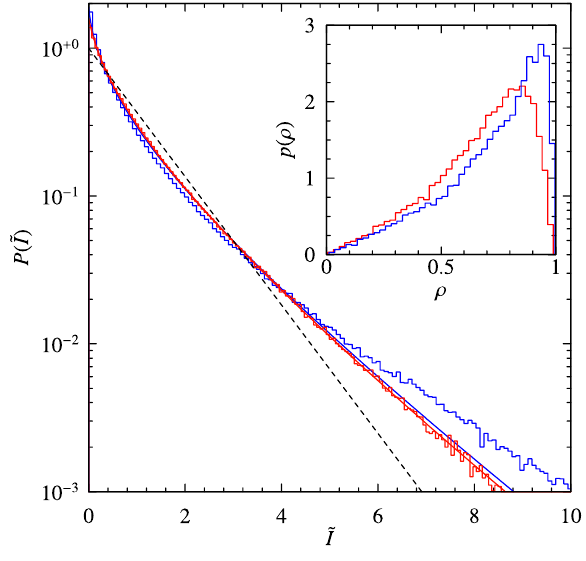
Figure 3: Empirical distributions of the normalised inten- sities: blue histogram for the conventional RC and red his- togram for the chaotic one. Comparison with the predic- tion Equation (6) (blue and red continuous curves) where the empirical p ( ρ ) was used (see inset with corresponding colors). The dashed black curve shows the exponential dis- tribution expected under Hill’s hypothesis